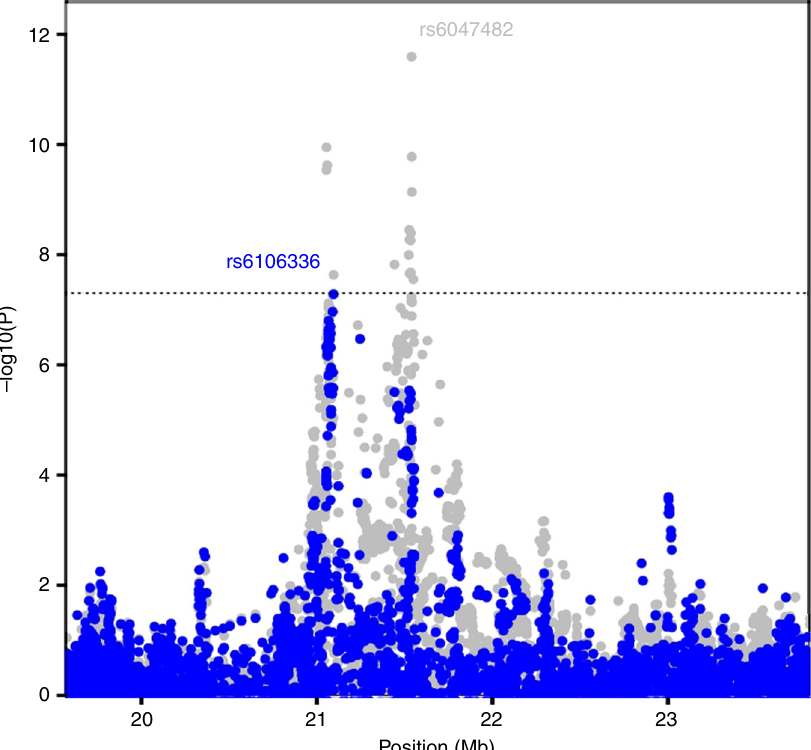
Fig. 2 Conditional analysis at the 20p11.22-23 region. Overall meta-analysis – log 10 P -values are plotted in gray in the background. In the foreground, meta- analysis – log 10 p -values when the top tagging SNP is the region (rs6047482) is conditioned on is plotted in blue. A second independent signal, tagged